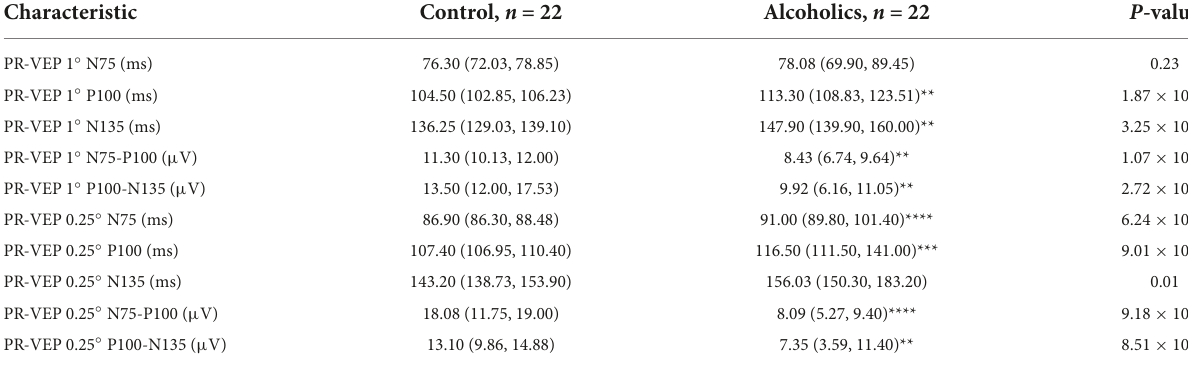
TABLE 3 Pattern-reversal visual evoked potential (PR-VEP) components